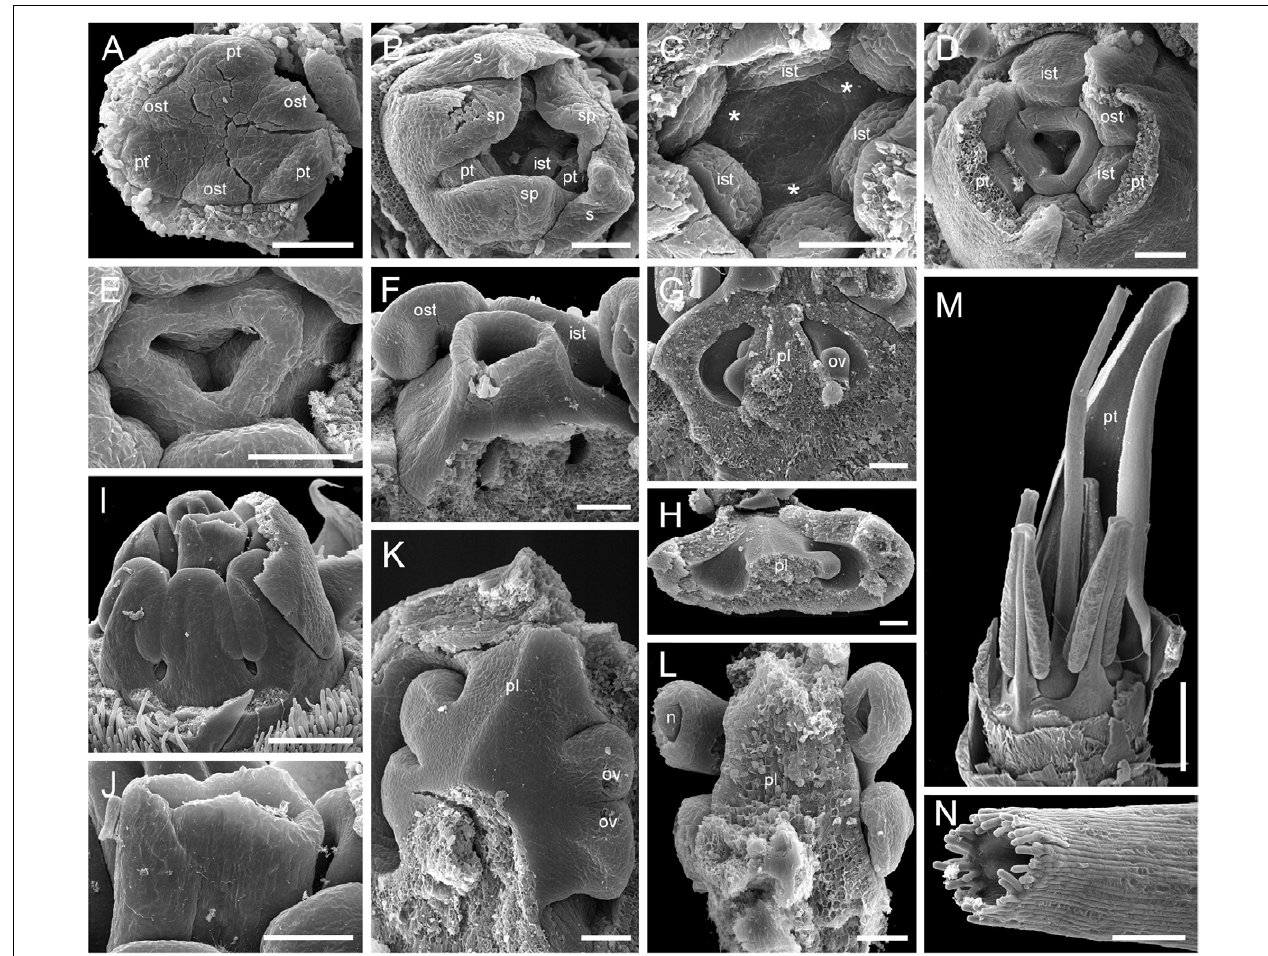
FIGURE 14 | Flower development in Saxofridericioideae-Schoenocephalieae. Guacamaya superba . (A) Initiation of petals and androecium. Sepals removed. (B) General view of flower at gynoecium initiation. (C) Gynoecium initiation as three separate carpel primordia. (D,E) Young gynoecium with prominent symplicate zone with placentae developing inside the ovary. (F) Gynoecium with partly dissected ovary showing very young ovules inside. (G,H) Stage similar to panel (F) . Dissected ovaries with placentae and young ovules. There are three parietal placentae formed by congenitally fused carpel margins at this stage. Symplicate zone. (I) General view of flower showing androecial tube. (J) Detail of panel (I) . Style with carpel tips. Note that carpels are congenitally united and there no lines of postgenital carpel fusion. (K,L) Isolated placenta (symplicate zone), stage similar to panel (I) . Views from gynoecium center (K) and from the ovary wall (L) . (M) Nearly mature flower with perianth removed. (N) Close up of the style tip in panel (M) . *, carpel tips; ist, inner stamen; ost, outer stamens; n, nucellus; ov, ovule; pl, placenta; pt, petals; s, phyllomes on RU axis; sp., sepals. Scale bars = 100 mkm in panels (A–H,K,L,N) , 300 mkm in panel (I) and 1000 mkm in panel (M)